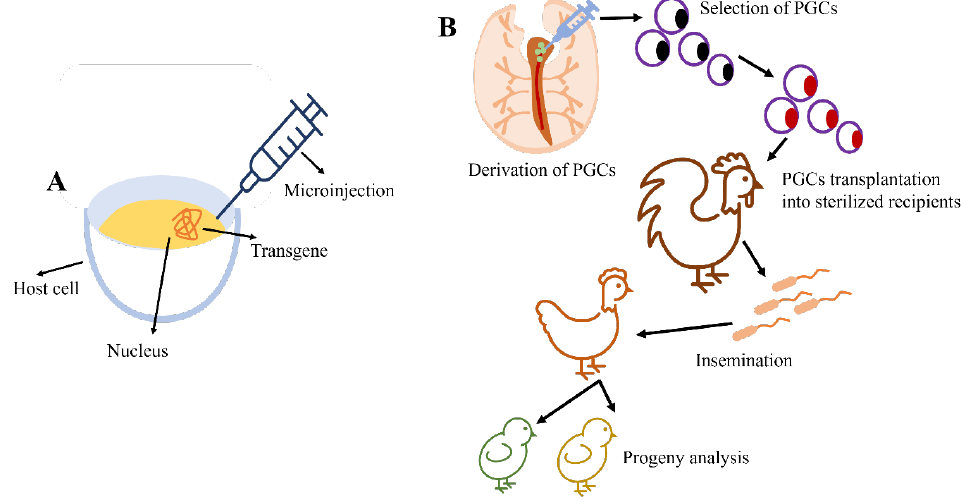
Figure 5. ( A ) Illustration of the DNA microinjection technique; ( B ) transgenesis in chickens using F igure 5. ( A ) Illustration of the DNA microinjection technique ; ( B ) transgenesis in chickens using PGCs ( m odified from Mozdziak and Petitte [29]). PGCs (modified from Mozdziak and Petitte